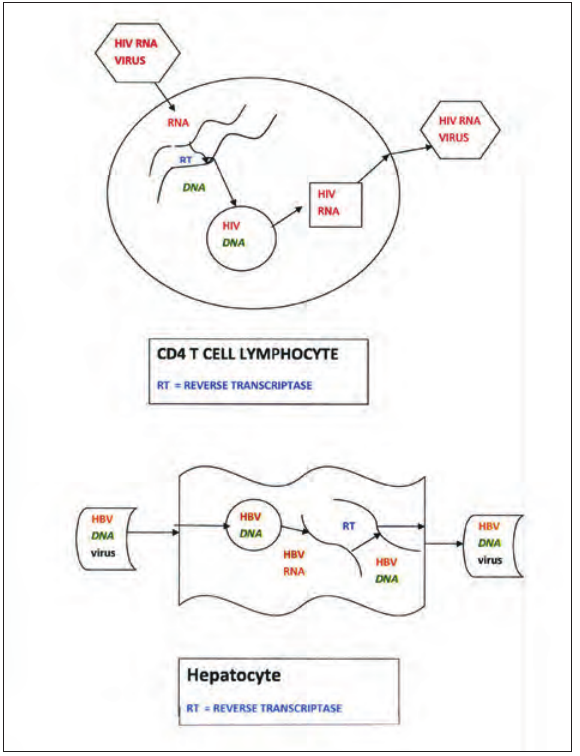
Fig.1. Simplified life cycle comparison of HBV and HIV– use of reverse transcriptase enzyme in viral